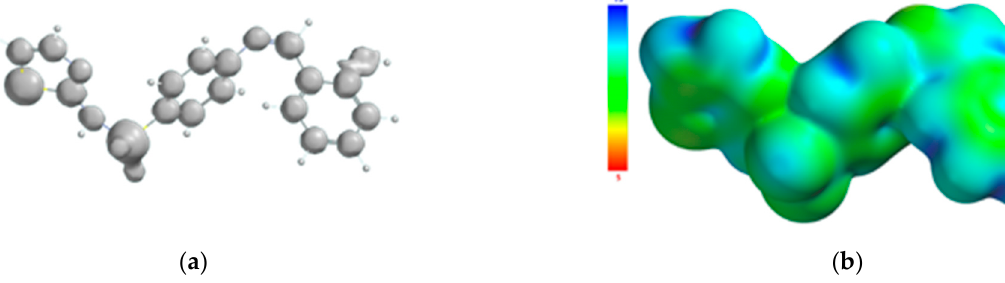
Figure 11. Isosurface of the ionization potential of the Schiff base ligand ( a ); ionization potential mapped on the surface of the total charge density ( b ).